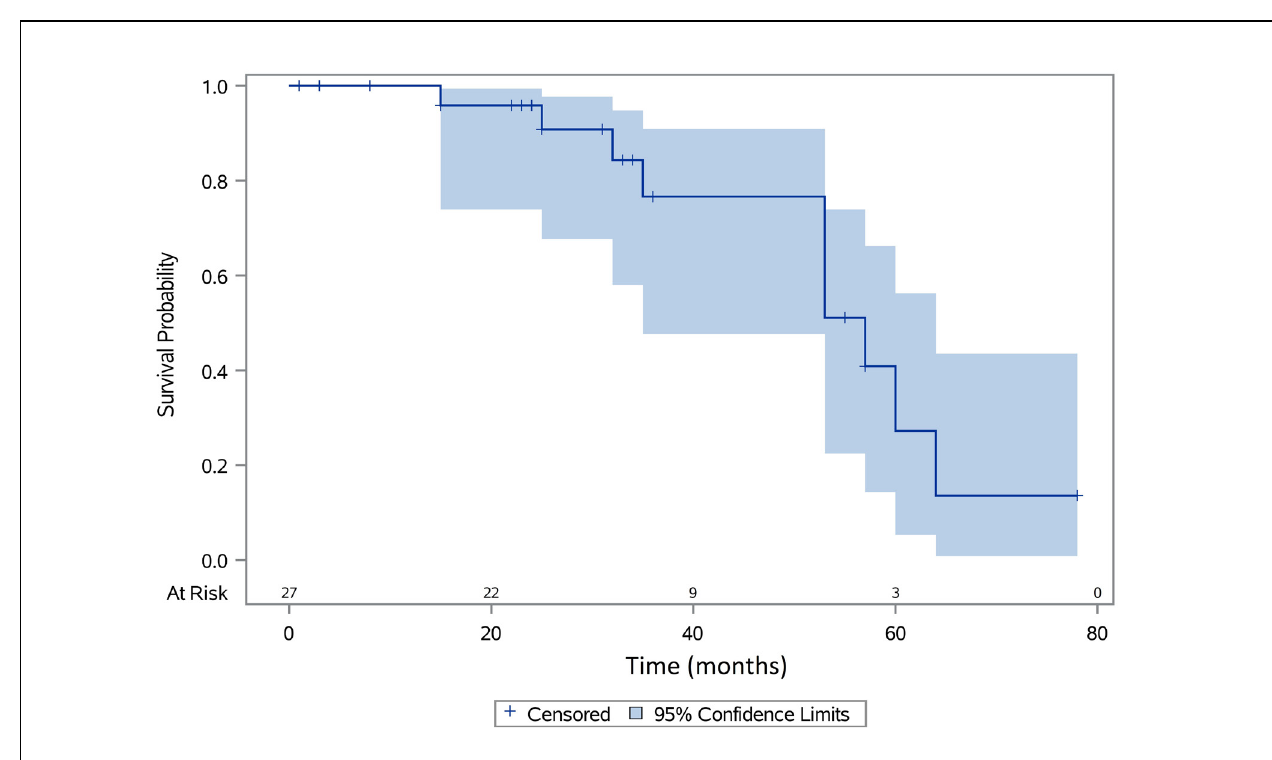
Fig. 1 - 5 year functional left ITAG rates with 95% CI and patients at risk according to Kaplan Meier